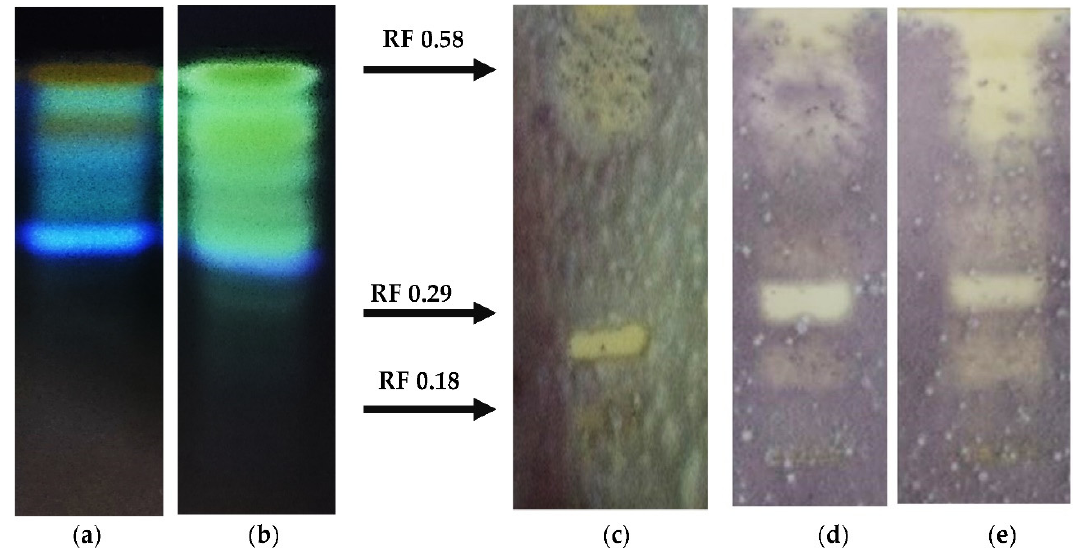
Figure 8. Thin layer chromatograms of ethyl acetate extracts of supernatants of B. velezensis BZR 336 g ( a ) and B. velezensis BZR 517 ( b ) and UV 366 nm and bioautograms of commercial lipopeptides ( c ) of ethyl acetate extracts of supernatants of B. velezensis BZR 336 g ( d ) and B. velezensis BZR 517 ( e ) with identified lipopeptide profiles: Rf 0.58—surfactin; Rf 0.29—iturin A (test culture of F. oxysporum var. orthoceras BZR 6).